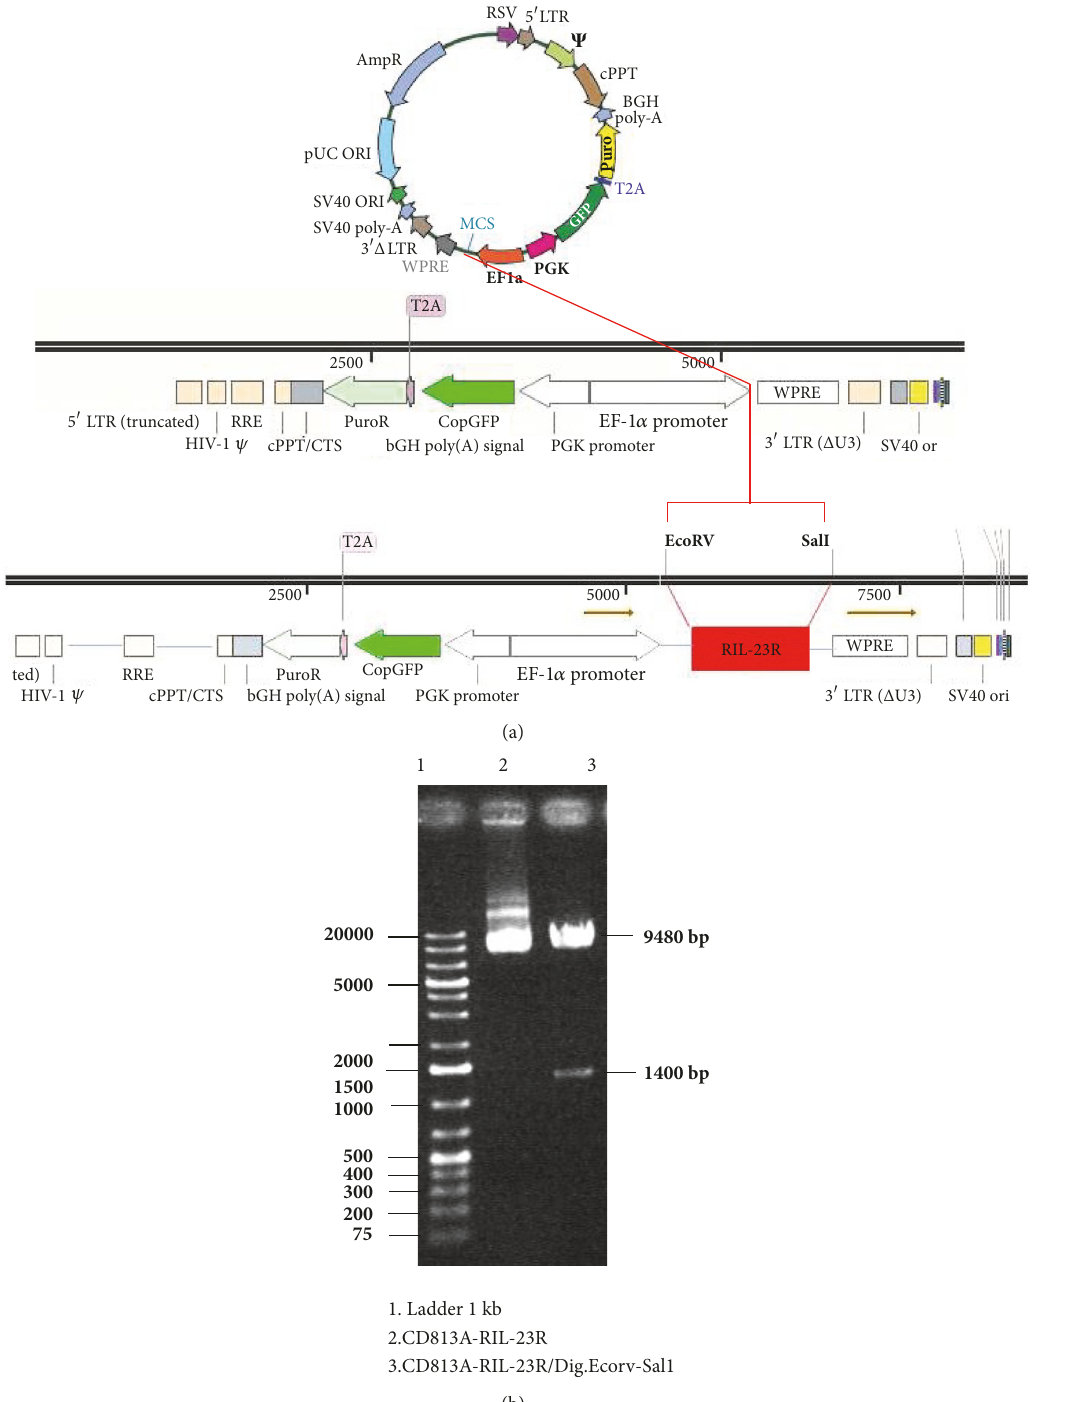
Figure 2: Recombinant IL-23R gene construct. (a) Recombinant IL-23R cDNA inserted into the pCDH-813A-1 lentiviral vector. (b) The presenceof a 1400 bp segment related to RIL- 23R and a segment of a 9480 bp related to pCDH-813A-1 confirmed that the cloning established. A genetic map confirmed these